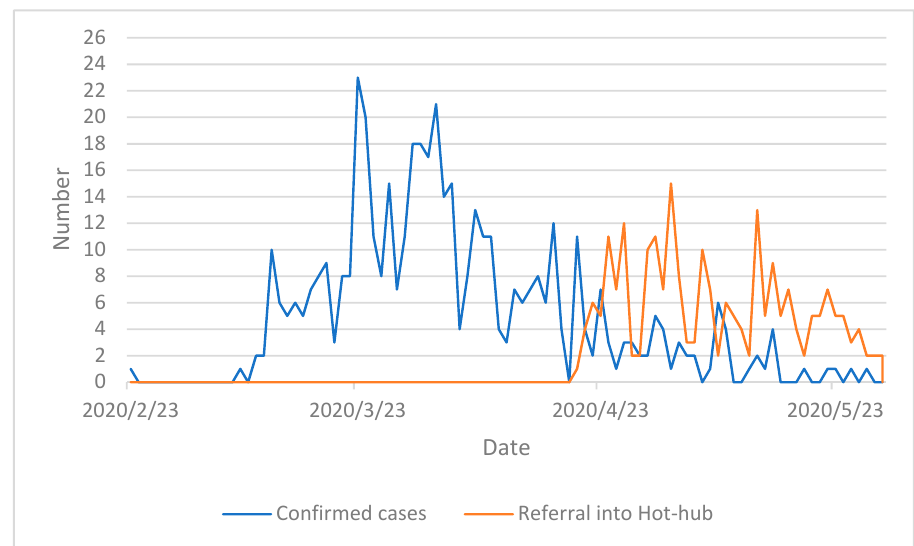
Figure 2. Number of new PHE lab confirmed COVID-19 cases in Islington and new referrals into the Islington Service [30].